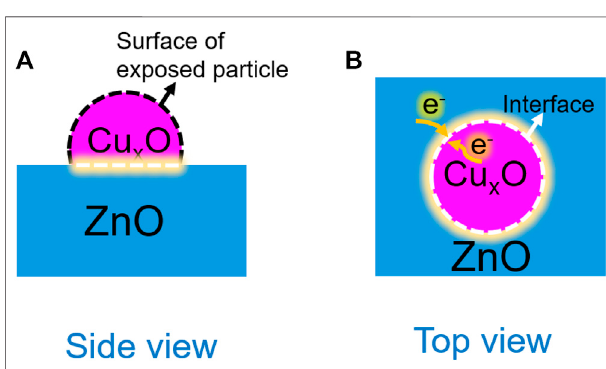
FIGURE 12 | Schematic of the interaction between Cu during the CO oxidation reaction. (A) : Side view; (B) TOP